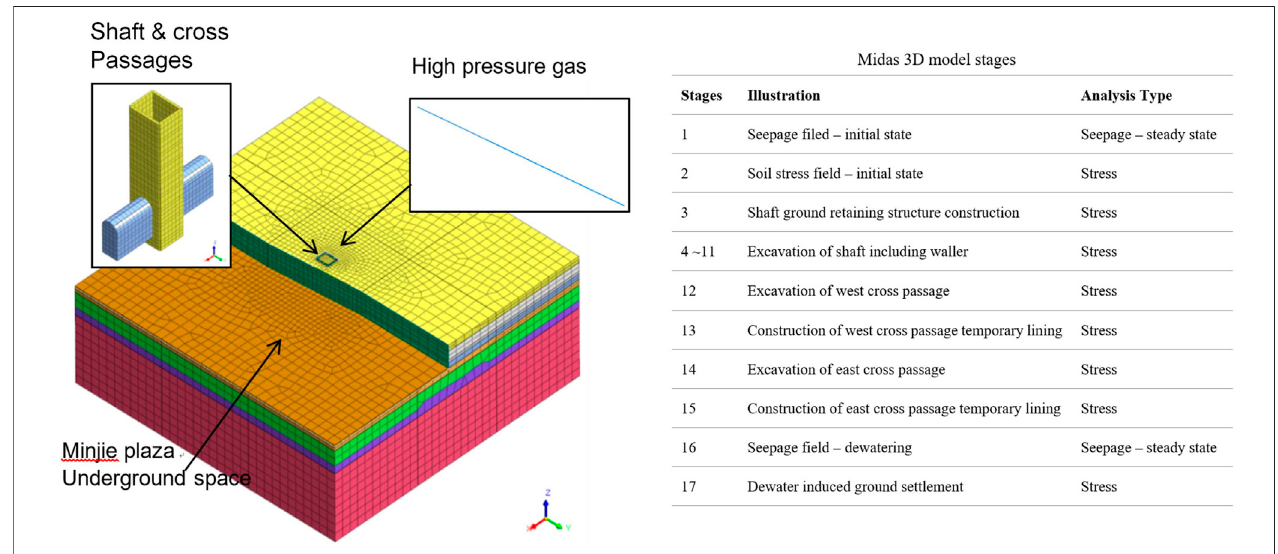
FIGURE 9 | 3D fi nite element model with detailed modelling stages.